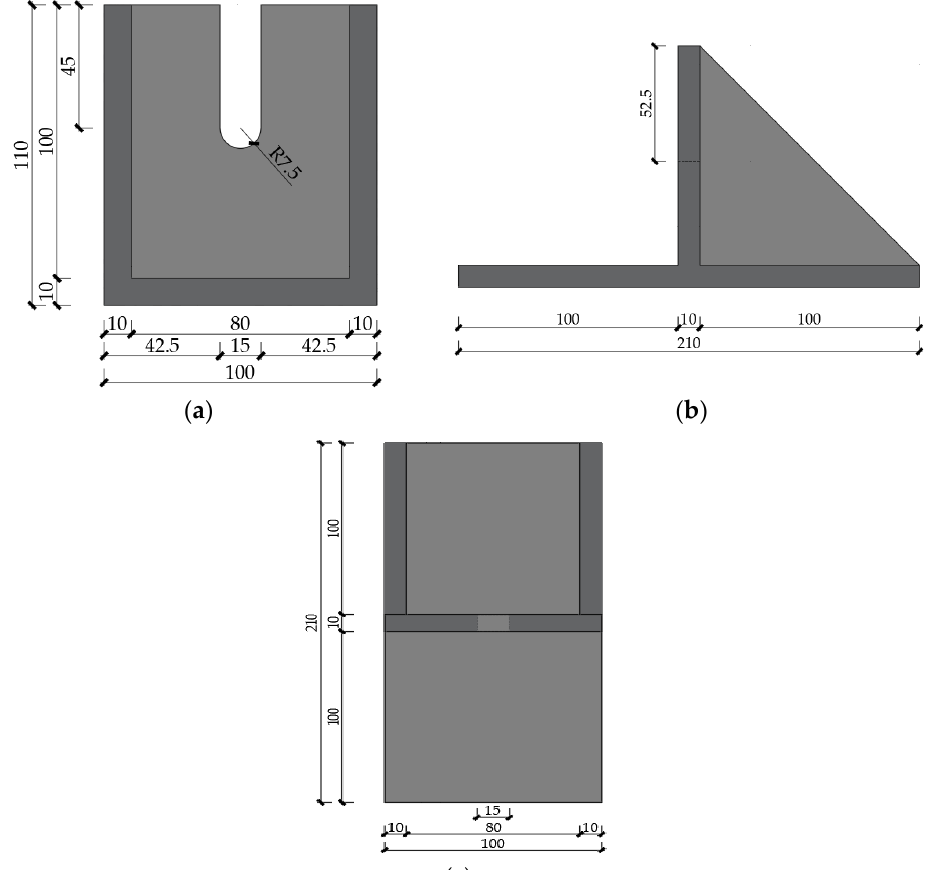
Figure 5. Geometric dimension and reinforcement distribution of the L-connector: ( a ) front view; ( b ) side view; ( c ) top view (units: mm).